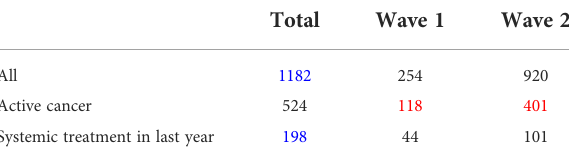
TABLE 1 Patient counts in our onco-COVID